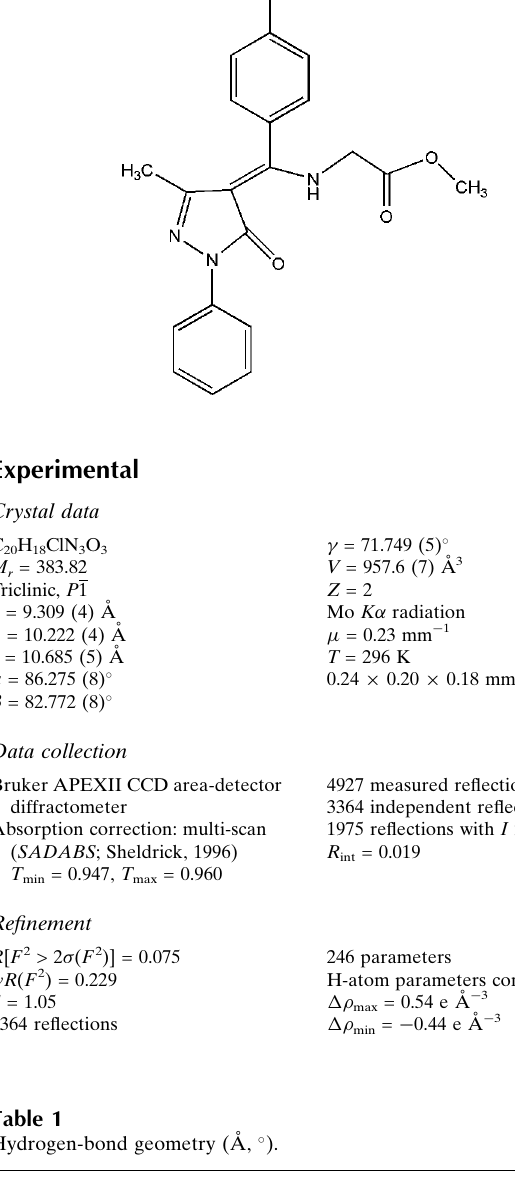
Hydrogen-bond geometry (A˚ , (cid:3)